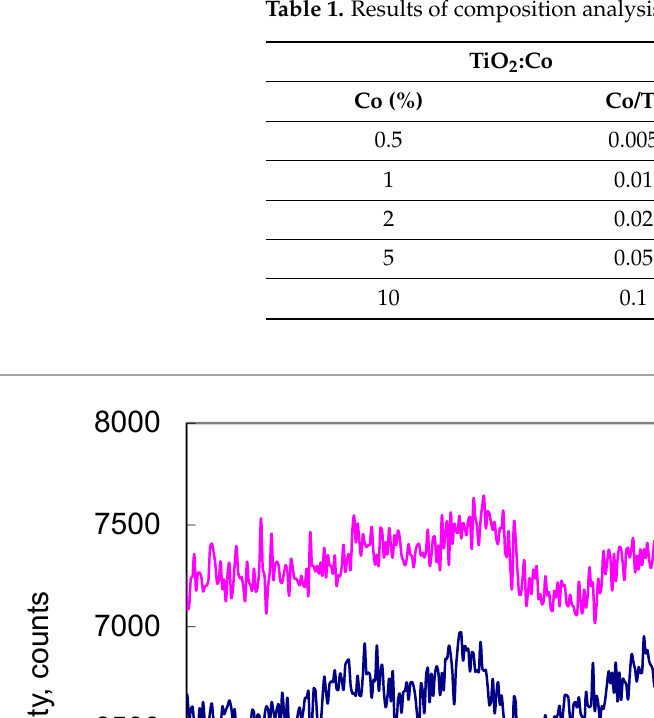
Table 1. Results of composition analysis by XPS and EDX of Co-–doped TiO 2 samples.